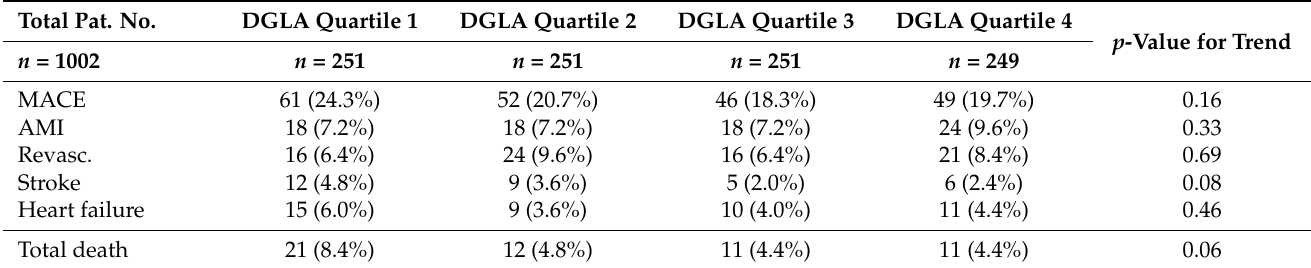
Table 3. Endpoints/adverse events by quartiles of DGLA. Total Pat. No.